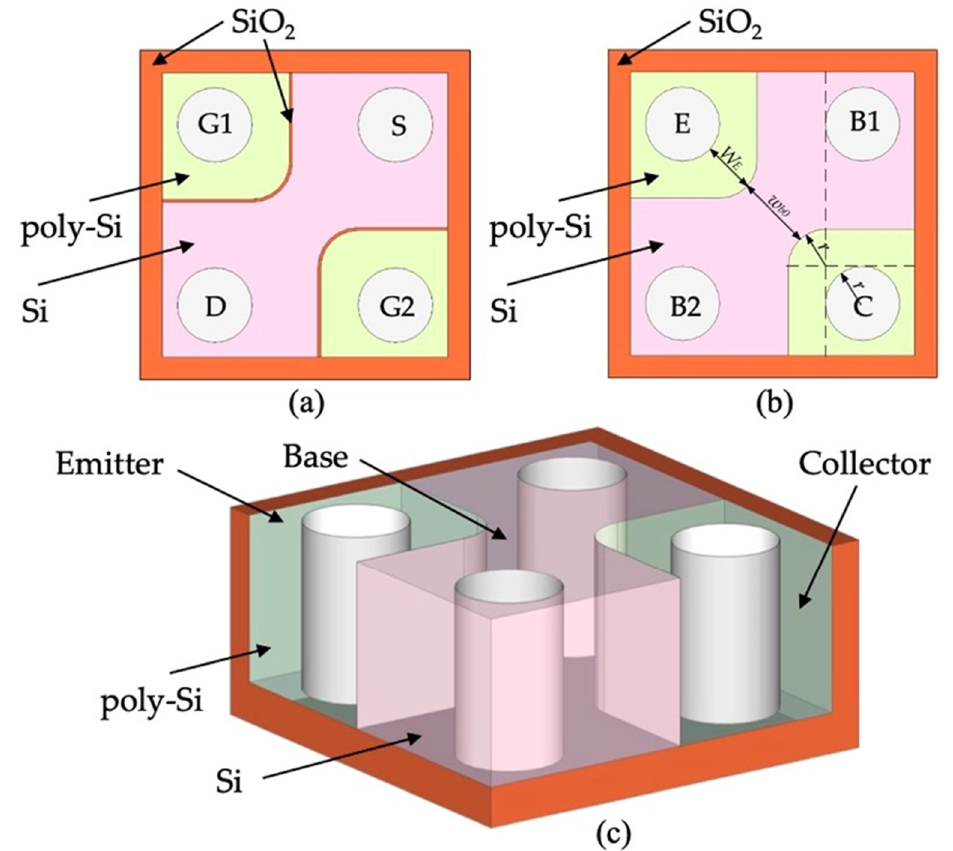
Figure 1. There are two types of elementary cells in VESTIC technology: ( a ) a cell with a junctionless field-effect transistor (VESFET, green—polycrystalline gate area, pink—drain, source, and “channel” area, orange—insulating silicon dioxide); ( b ) a cell with a junction bipolar transistor (VES-BJT: green—polycrystalline emitter and collector, pink—base region, orange—insulating silicon dioxide); note that the junction field effect transistor [17] has the same structure; ( c ) 3D view of the elementary cell (with removed trench isolation in the front of view).